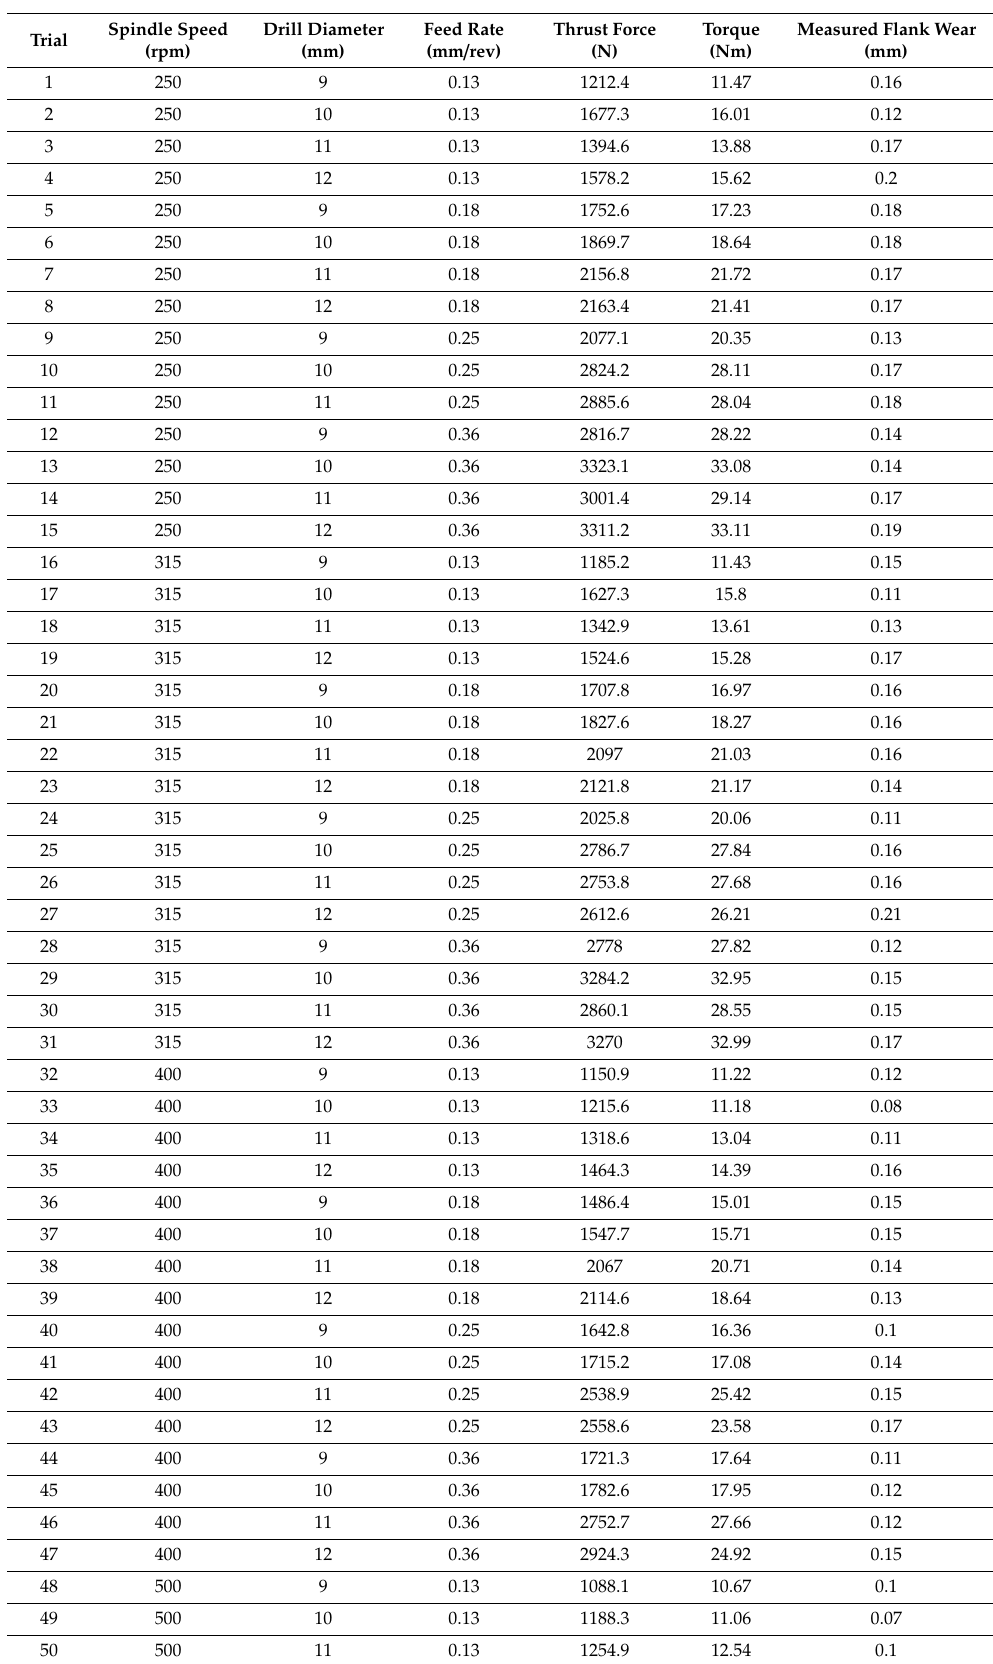
Table 7. Experimental Data for Cast Iron workpiece